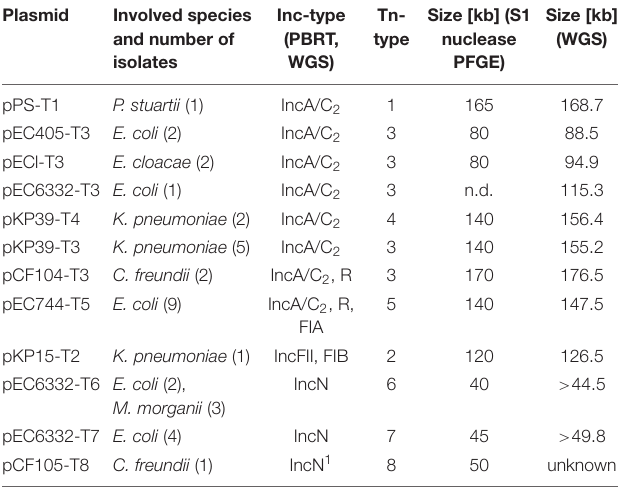
TABLE 1 | Characteristics of NDM-1 encoding plasmids of this study. Plasmid Involved species and number